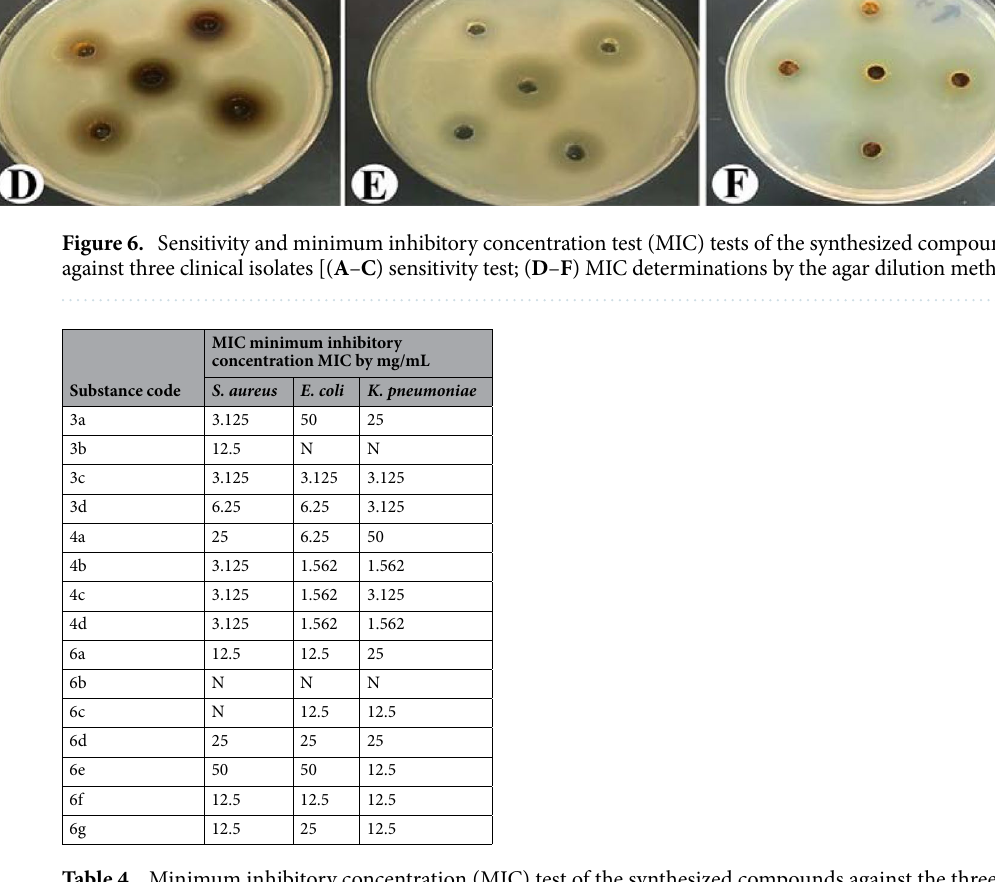
Table 4. Minimum inhibitory concentration (MIC) test of the synthesized compounds against the three tested clinical isolates. N, no zone of inhibition was present.